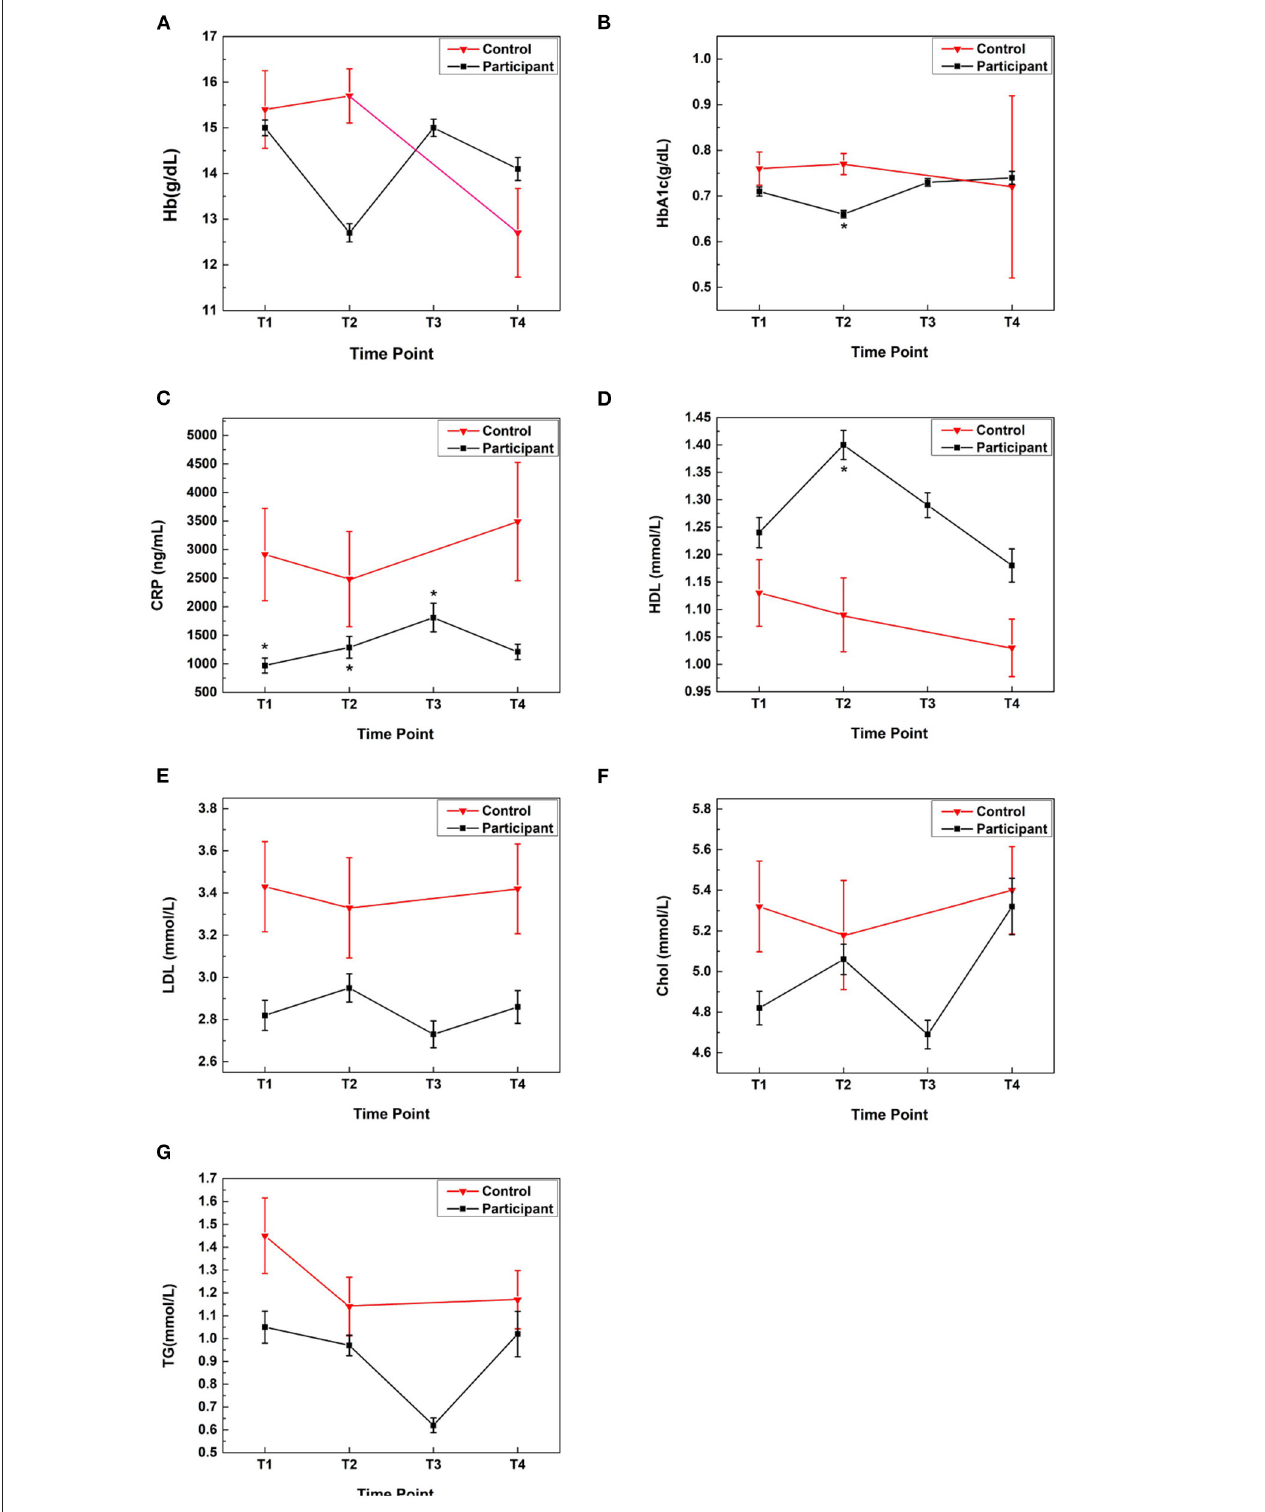
FIGURE 5 | Comparisons of blood biomarkers in Samyama participants and controls: blood biomarker data was analyzed for four timepoints (T1 = baseline; T2 = immediately before retreat; T3 = immediately after retreat; T4 = 3 months after retreat). Biomarkers measured were: (A) Hemoglobin, (B) HbA1c, (C) CRP, (D)